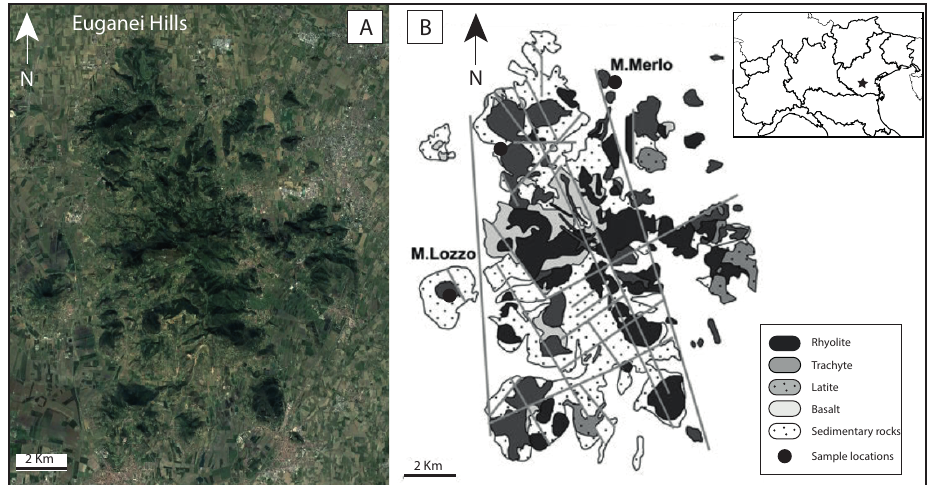
Figure 1. Modified from [6] showing the location and geology of Euganean Hills. ( A ) satellite map. ( B ) Schematic geological map of the Euganean Hills with sample locations and main faults. Inset location of the Euganean Hills (star symbol) in Northern